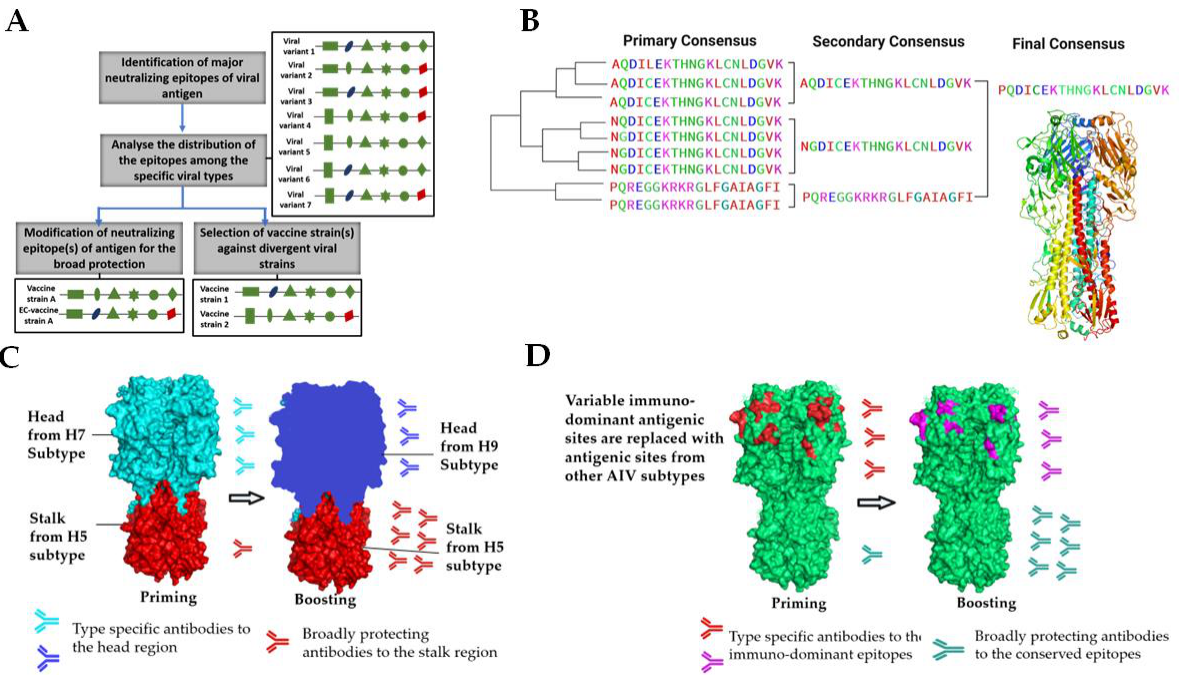
bodies against distinct clades of H5N1 viruses and were protected against lethal challenge by different clades of H5N1 viruses [170]. Another study modified neutralizing epitopes of an existing HA to accommodate circulating H9N2 epitopes to generate a